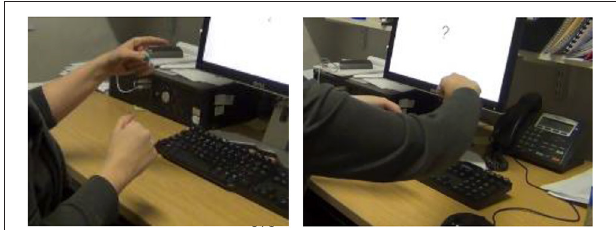
enactment of steering a motorbike (photograph on the right).